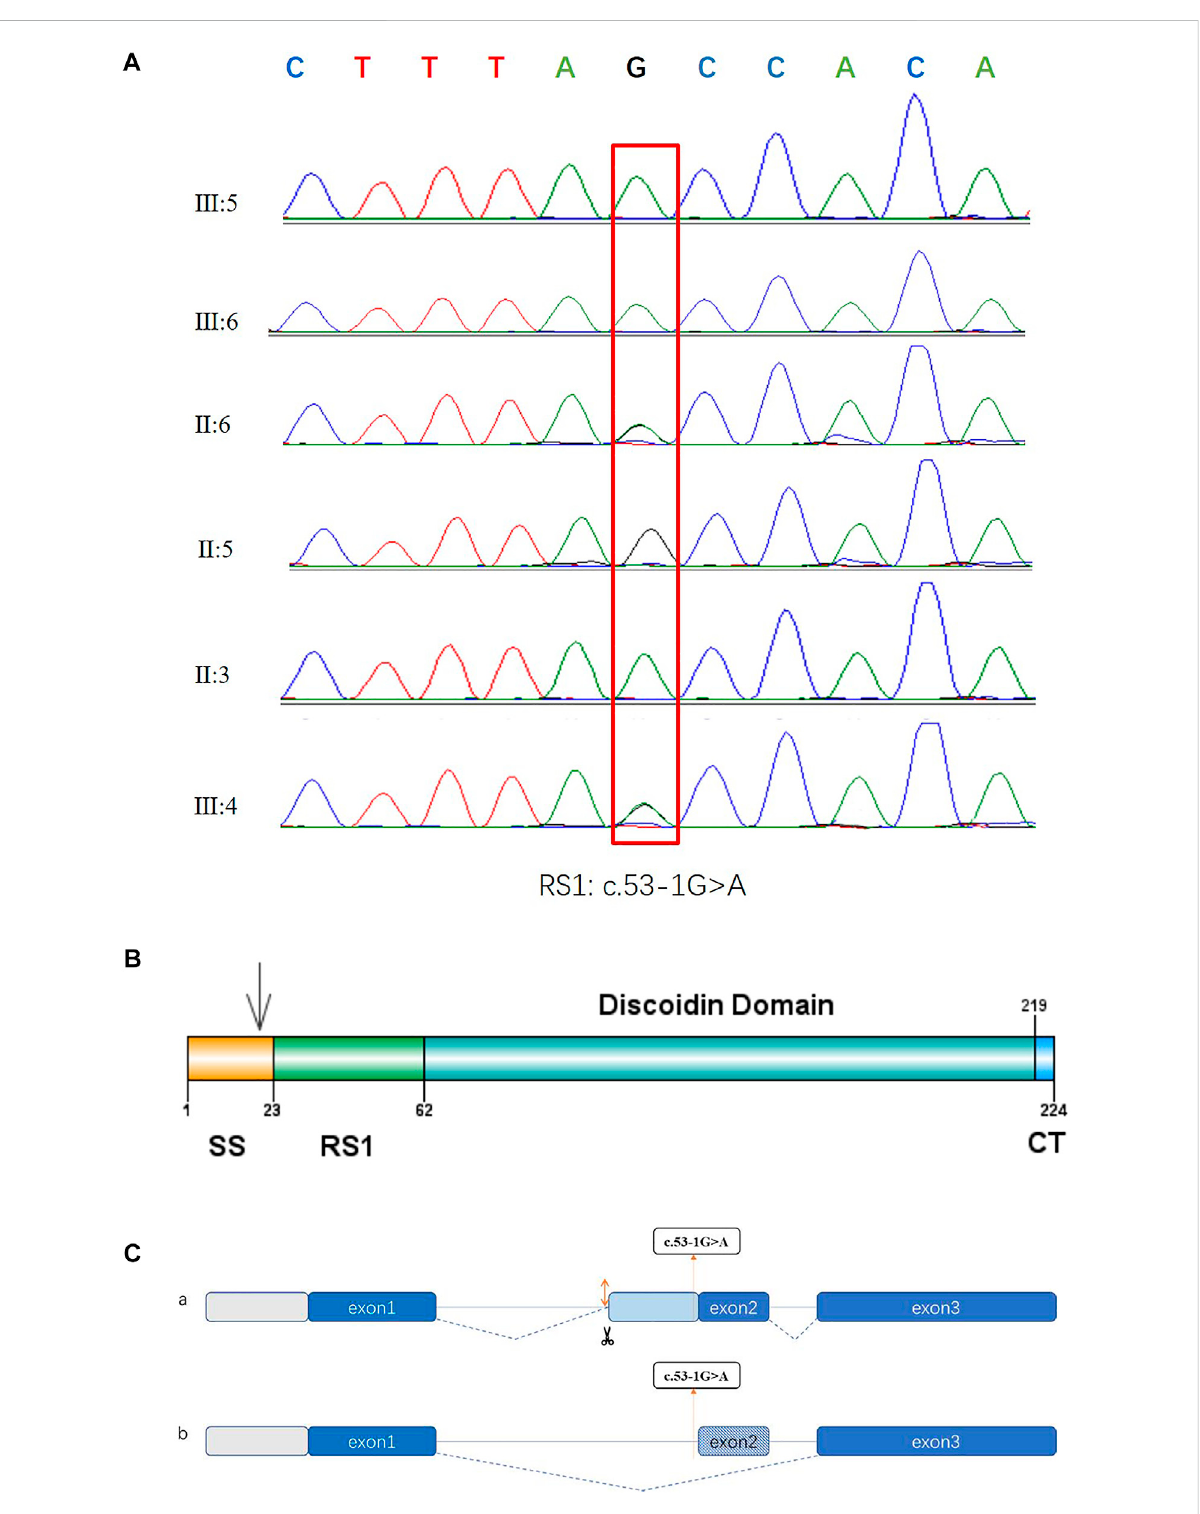
FIGURE 4 Sequencing diagrams of theRS1 mutation, domain diagram of theRS1 proteinand prediction results ofsplicepattern of theidenti fi ed mutation inthisstudy. (A) Redbox indicatesthemutationsite. (B) The RS1proteincomprises threedomains. SS:N-terminalsequenceorsignalsequence.RS1: RS1 domain. DS: Discoidin domain. CT: C-terminal segment. (C) Two predictive splice patterns. (a) Insertion of 29 bp into intron 1 causes alternative splicing acceptor,leadingto aframeshift andthe premature termination oftranslation. (b) 26 bp deletion atspliceregion causes exon skipping, resulting in a frameshift and the premature termination of